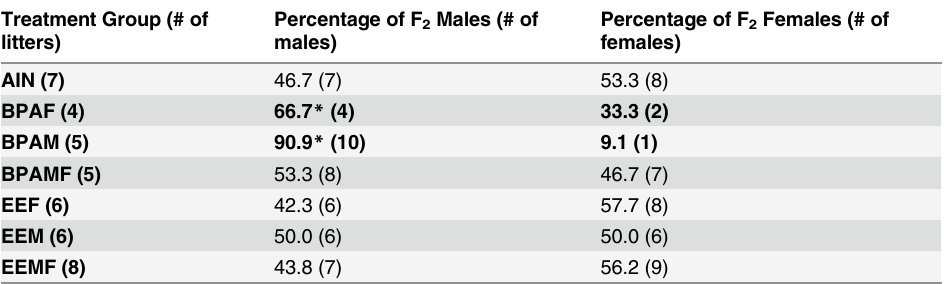
Table 1. Sex ratio of F 2 pups from the various F 1 treatment groups.